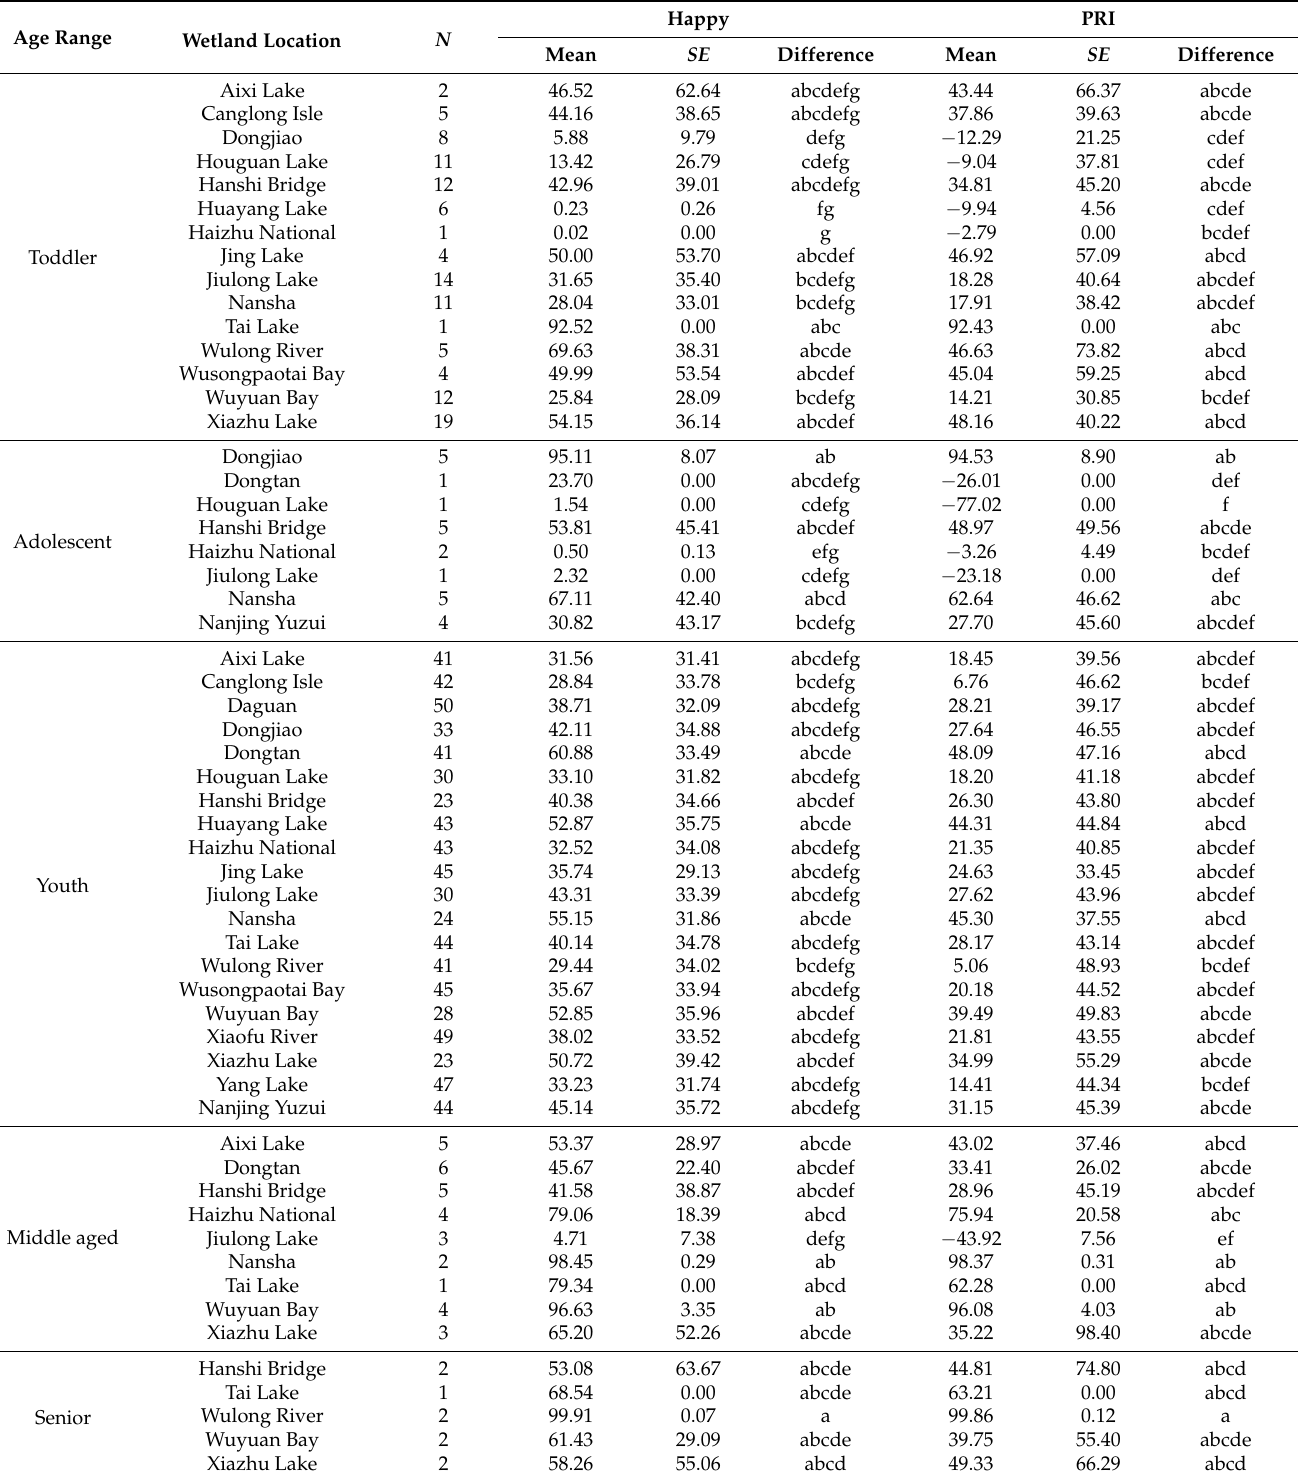
Table 3. Differences of happy and positive response index (PRI) scores for visitors in varied age ranges among wetland parks at different